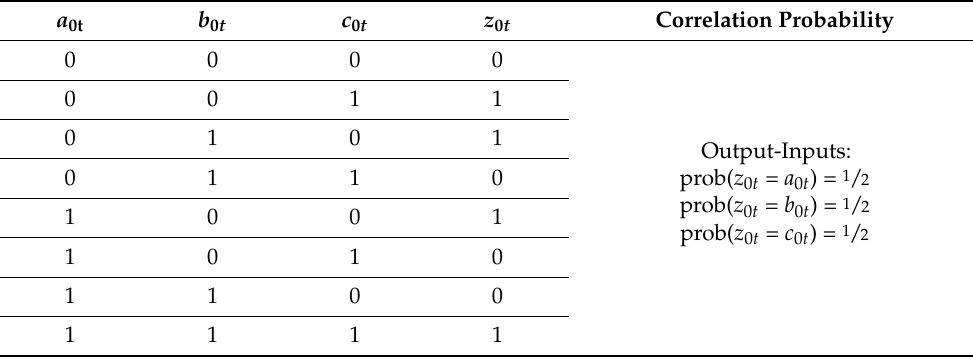
Table 5. Correlation probability of OSG 0